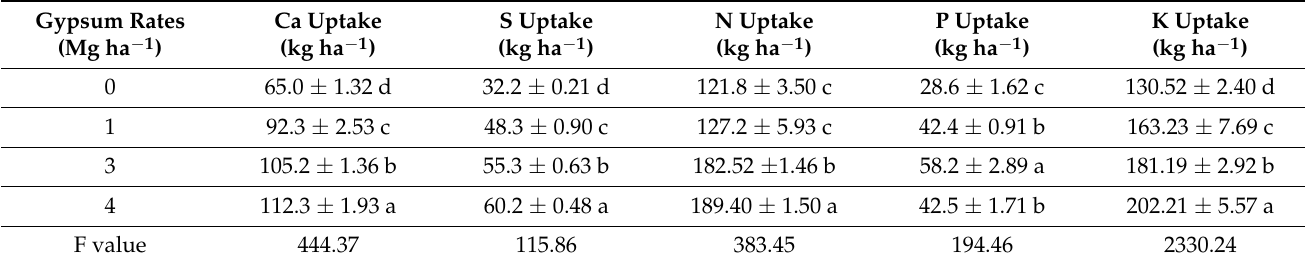
Table 2. Macronutrients uptake of plants affected by different gypsum application